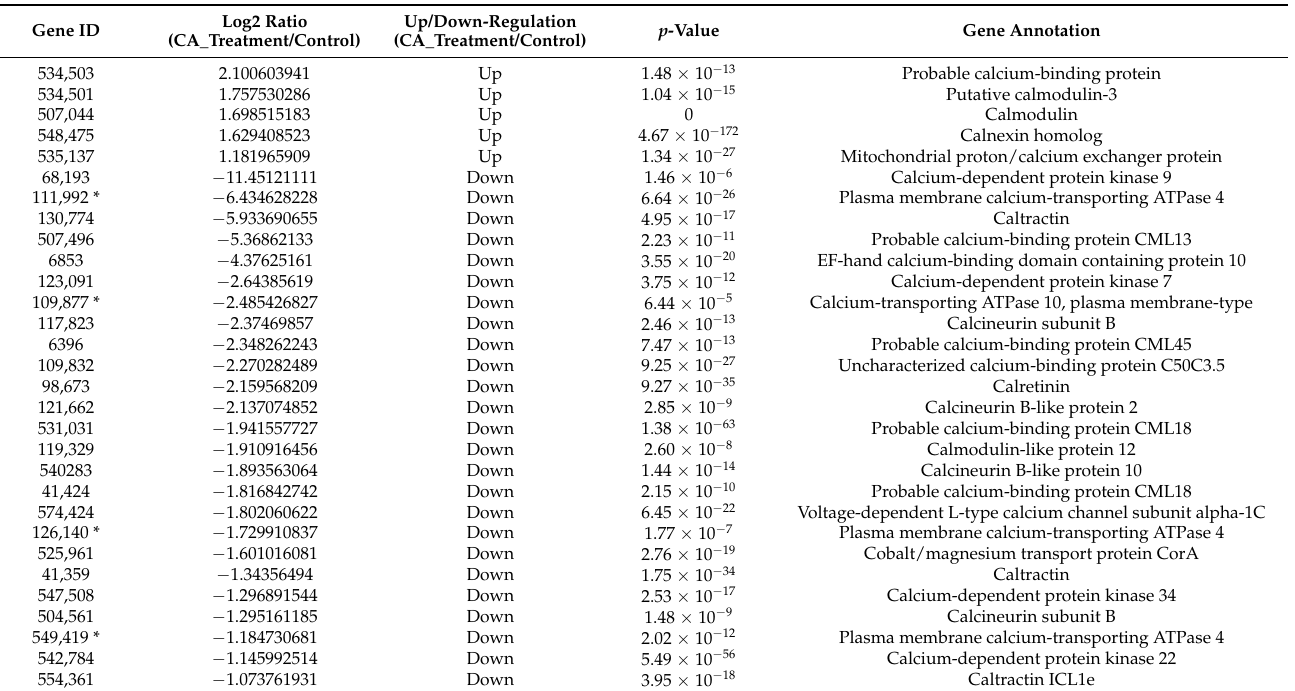
Table 2. Summary of DEGs encoding calcium-related